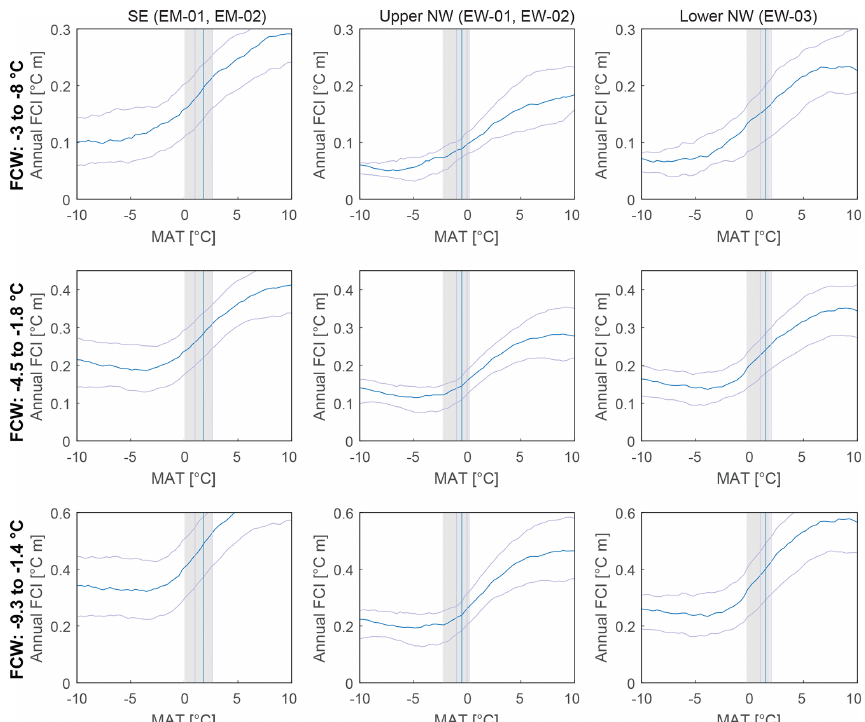
Figure B1. FCI sensitivity to different frost cracking windows (FCW) for the frost cracking model, with standard model inputs from Andersen et al. (2015) in the upper row and two windows from Draebing et al. (2017b) in the middle and lower row. These are dependent on the mechanical bedrock properties and were originally calculated for anisotropic slaty paragneisses. Shaded area corresponds to reconstructed historical temperature range; vertical bars indicate modern mean, min, and max MAT conditions, and curves represent the corresponding d T a and d T d conditions. Note the different y -axis scale for the FCI of each row.